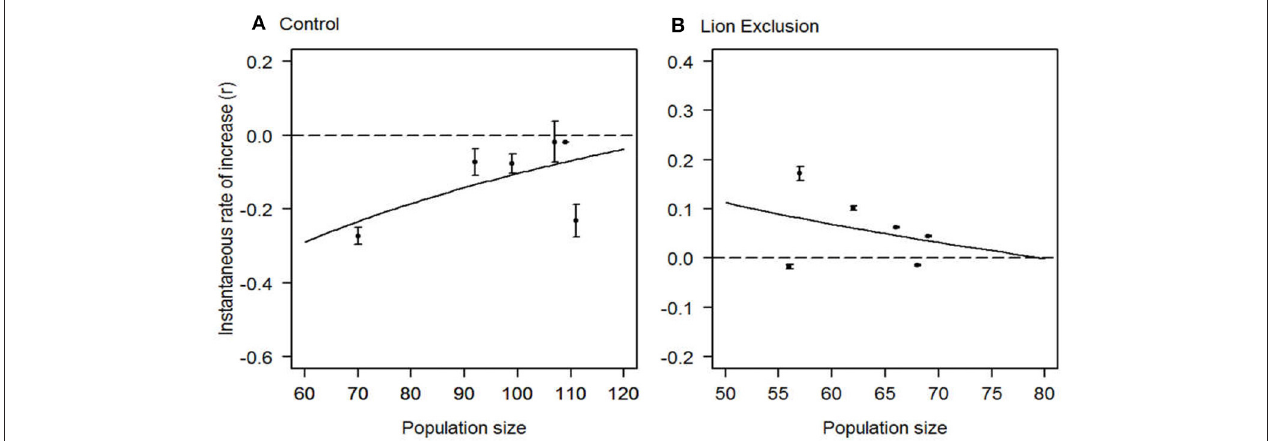
FIGURE 2 | A lion-mediated Allee effect in hartebeest populations. Correlations between annual instantaneous rates of increase ( r ) for hartebeest populations in (A) control zones exposed to lion predation ( r = 0.37 * ln(population size) − 1.79); and (B) lion exclusion zones [ r = − 0.241 * ln(population size) + 1.06] from 2009 to 2015. Error bars are 95% confidence intervals based on sampling variance of population estimates.